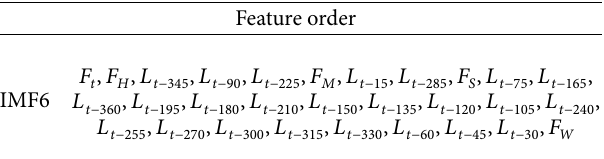
Figure 5: The mRMR value of each influencing factor feature. Table 3: The order of the IMF6 candidate feature sets.